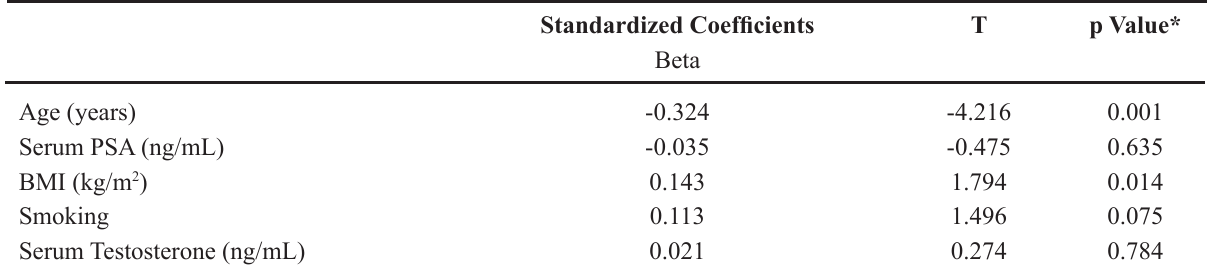
Table 5 – The factors associated with bone loss in Group II (benign prostatic hyperplasia